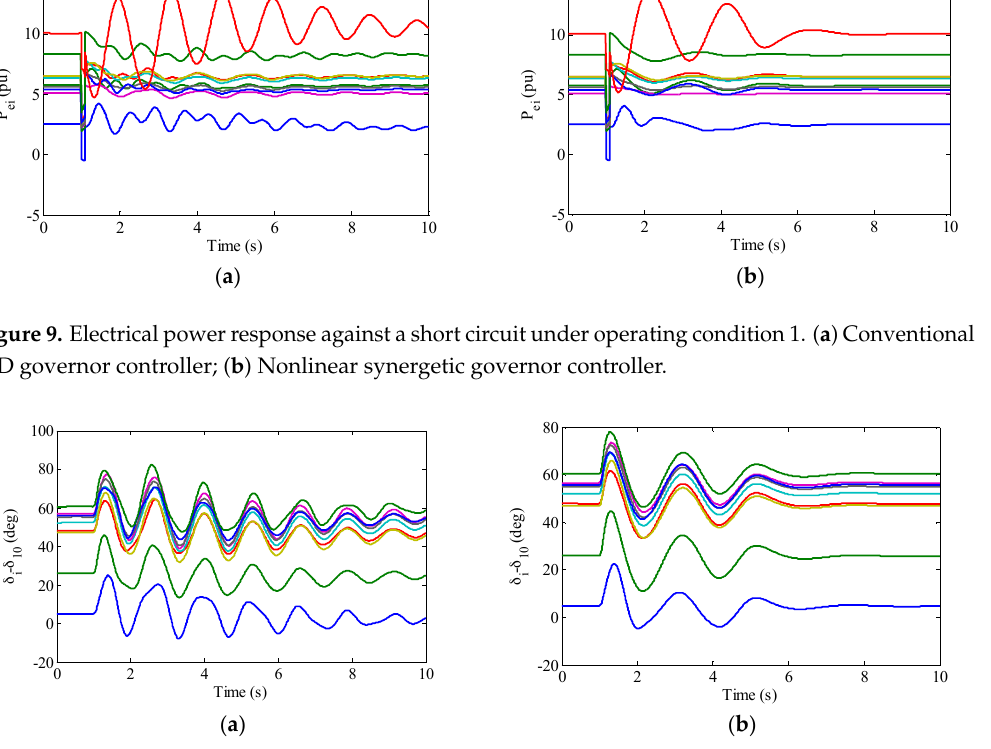
Figure 10. Rotor angle δ i - δ 10 response against a short circuit under operating condition 1. ( a ) Conventional PID governor controller; ( b ) Nonlinear synergetic governor controller.